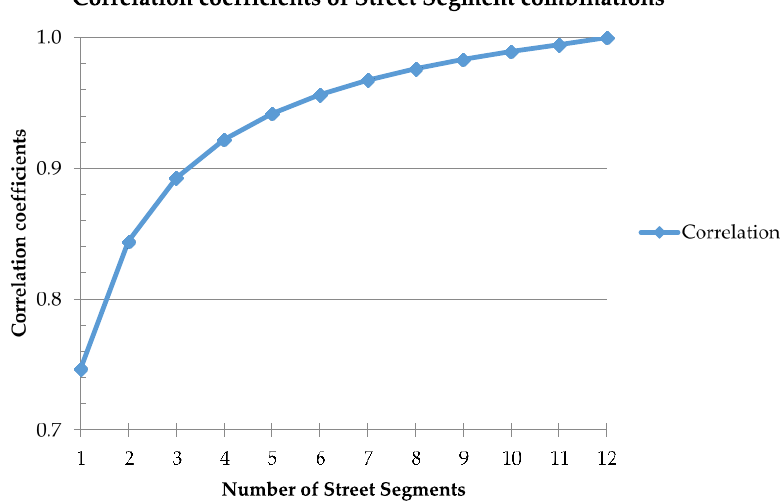
Figure 2. Correlation coefficients obtained from street segment combinations coding. Combination coefficients were generated by code developed in Statistical Analysis Software which runs a series of combinations of scores from one street segment up to twelve segments (i.e., 12 C 1 , 12 C 2 … 12 C 12 ) per participant, simulating all possible ways in which a certain number of street segment scores can be randomly chosen from the overall 12 street segment scores, without any repeated segment combinations. The code calculated means for the selected combinations then averaged the means across all participants to obtain overall combination means (i.e., overall means for 12 C 1 , 12 C 2 … 12 C 12 ). Spearman calculations used to determine associations between overall segment combination means (i.e., 12 C 1 , 12 C 2 … 12 C 12 ) and participants’ segment means.